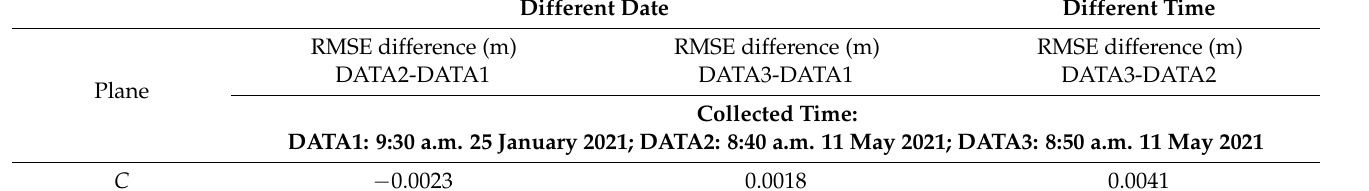
Table 14. The comparison of RMSE difference of each check plane for the three datasets after calibration. Different Date Different Time